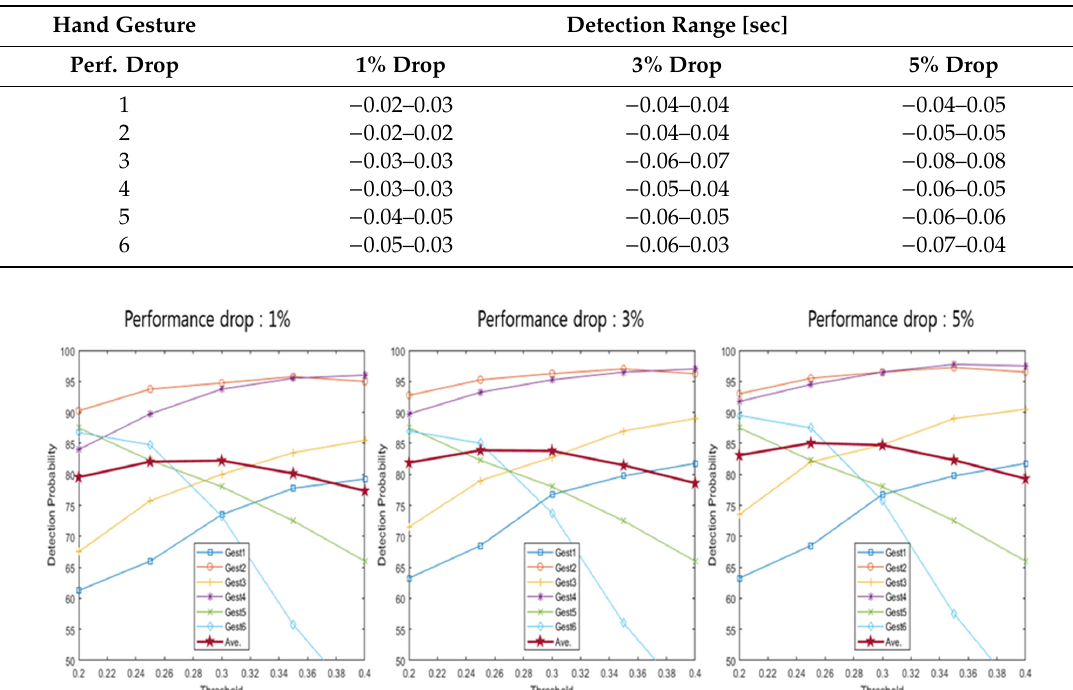
Table 1. Detection range of each hand gesture.